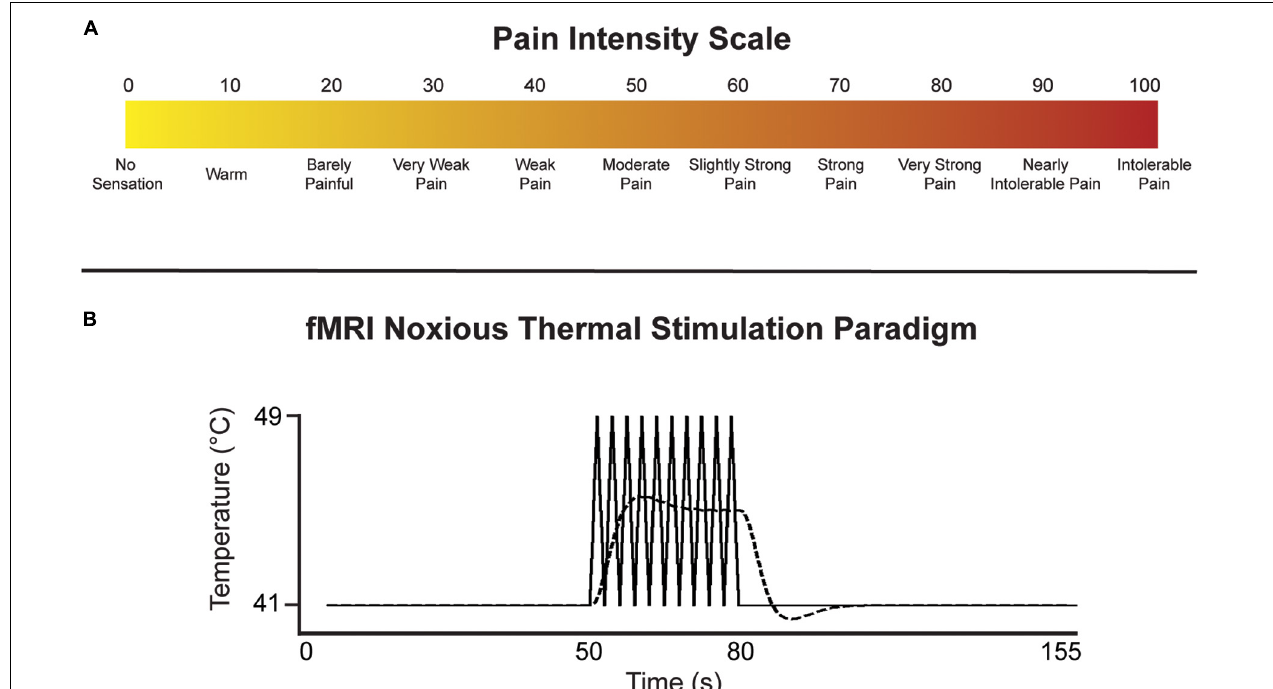
FIGURE 1 | (A) Numerical pain intensity scale used to calibrate participants in the Mood and Music studies, and to allow participants to rate their level of pain to the thermal stimulus during each fMRI run in all studies. (B) Noxious thermal stimulation paradigm used for each study. The solid line represents the baseline temperature and the block-like noxious stimulation spikes in temperature over 8 ◦ C. The indicated temperatures were used in the ID study, while participants were individually calibrated in the Mood and Music studies. The dashed line represents the predicted BOLD response.